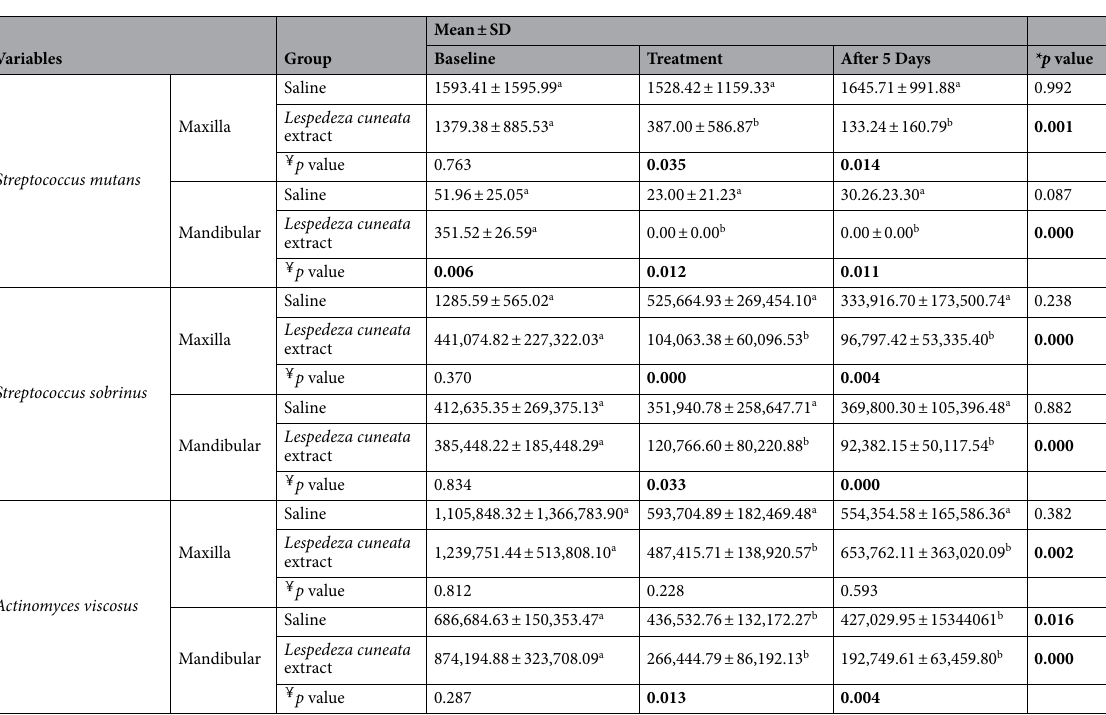
Table 5. Clinical outcomes observed between the groups. ￥ p values are determined by independent t test, * p values are determined by one-way ANOVA and Tukey tests ( p < 0.05).; Values are means ± standard deviations; significant